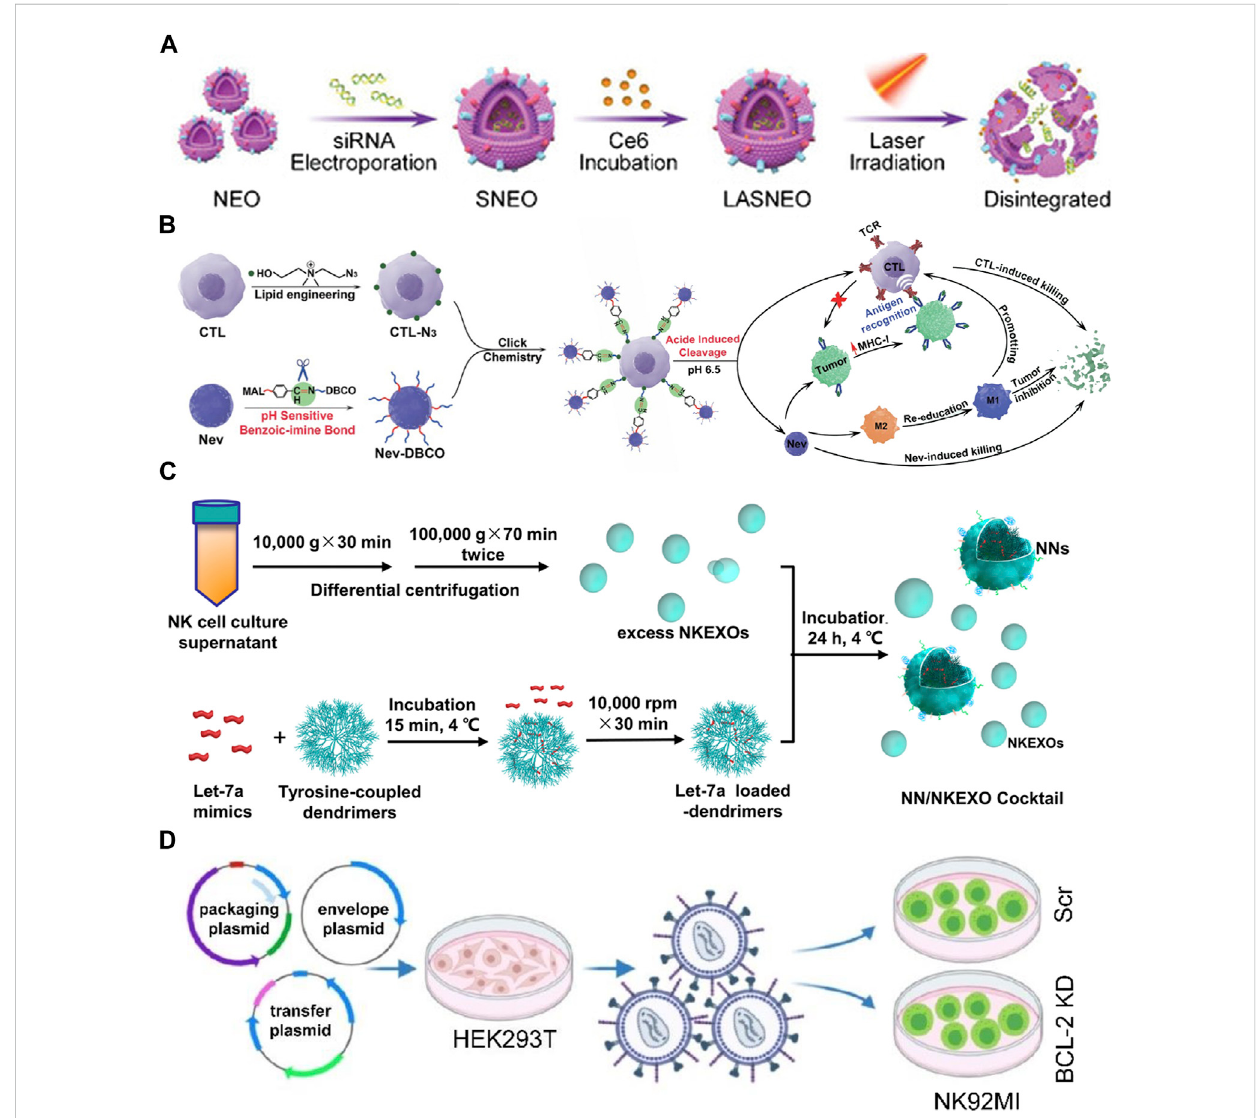
FIGURE 4 (A) Schematic illustration of light-activatable silencing NK-derived exosomes (LASNEO) mediated synergetictumor eradication. (B) Binding of NEVs to CLTs via click chemistry reaction. (C) Schematic design of the NN/NKEXO cocktail for tumor targeting and drug delivery. (D) Loading of BCL-2 siRNAs (siBCL-2) in NK-92MI-derived EVs by lentiviral